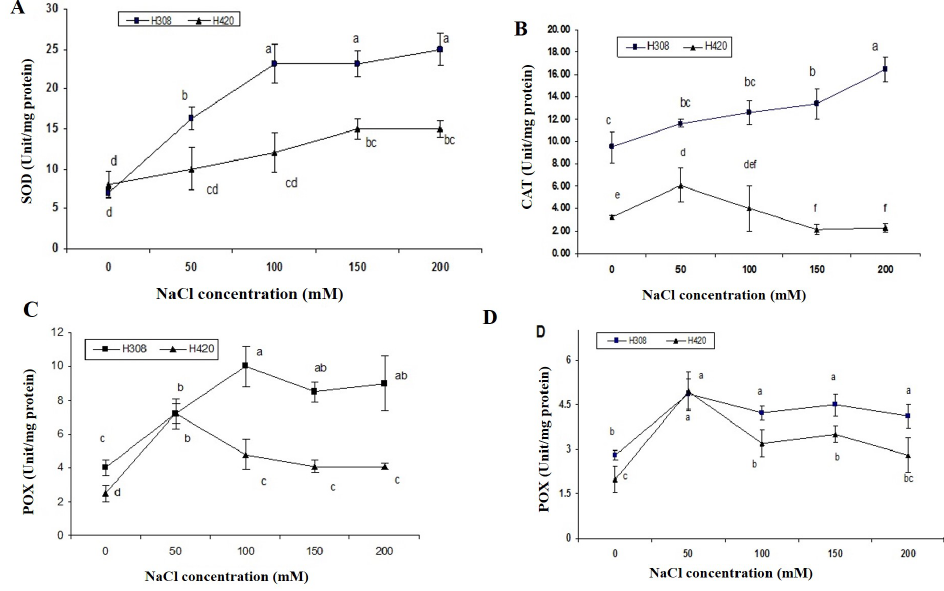
Fig. 6. Effect of various salt concentrations on the activities of SOD (A), CAT (B) POX (C) and APX (D) in leaves of two canola genotypes (H420 and H308).Values are mean ± SE (n=3). Means followed by the same letter did not significantly differ at P ≤0.05 according to Duncan’s multiple range